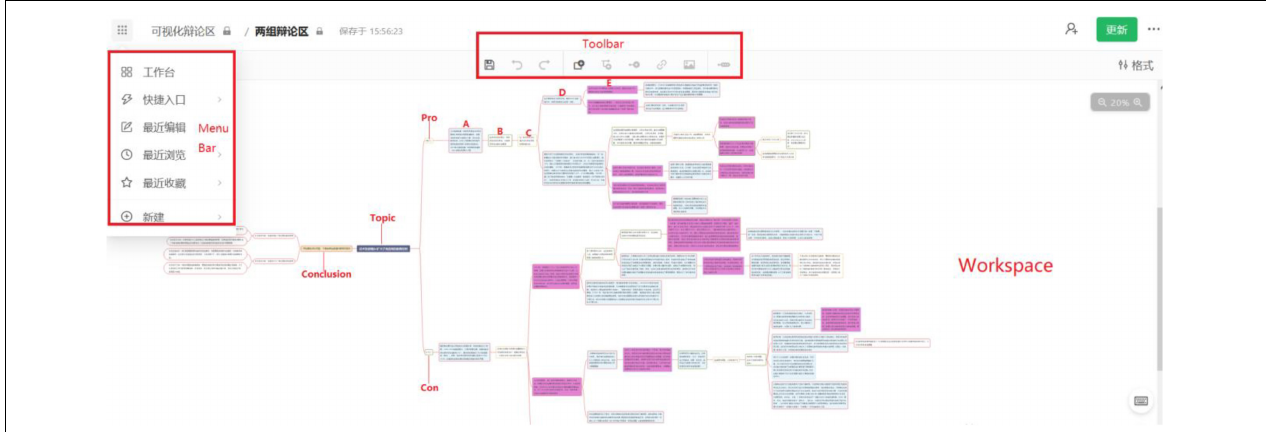
FIGURE 1 | Example of an AM-supported online group debate activity. Reproduced with permission from Zhejiang